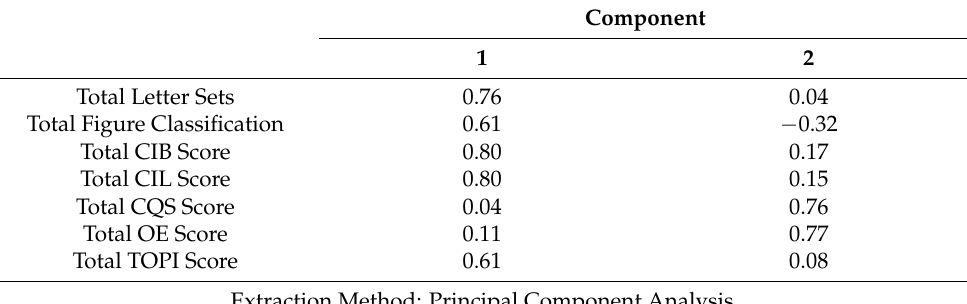
Rotation Method: Varimax with Kaiser Normalization